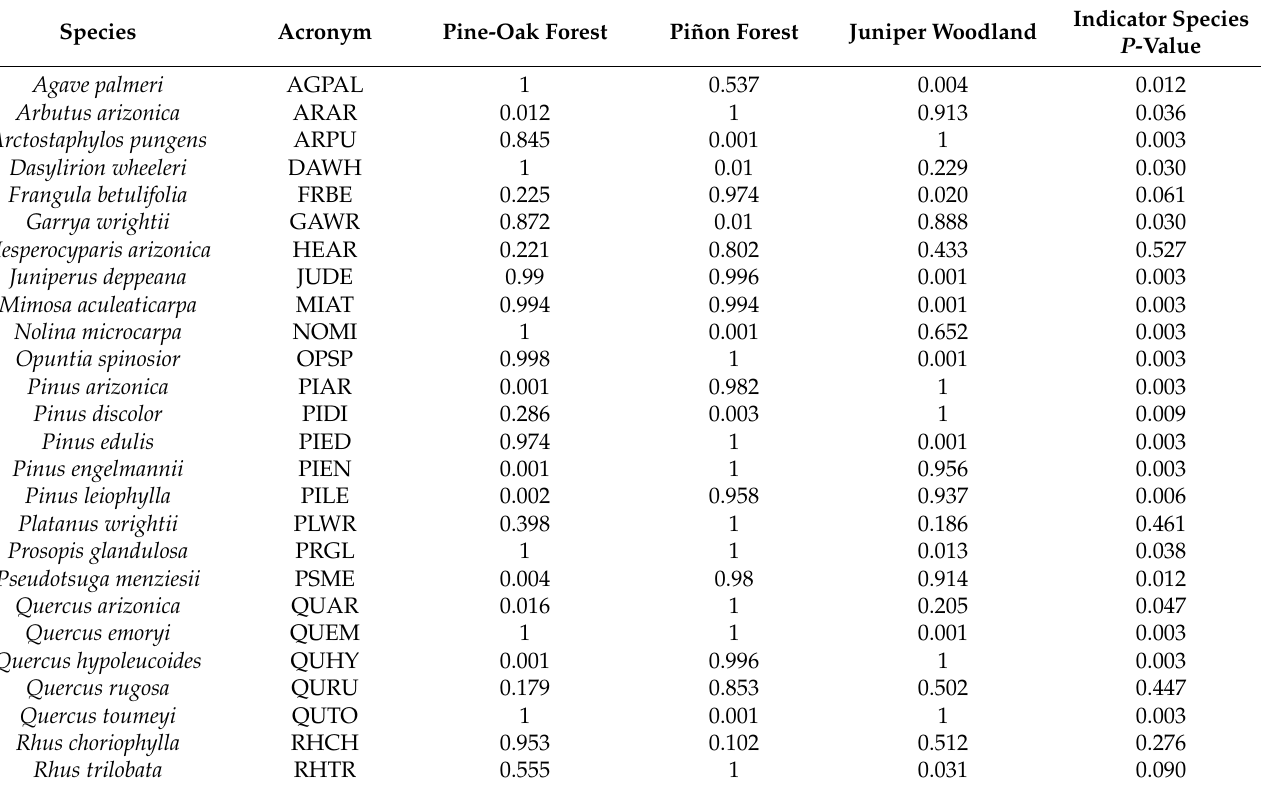
Table 3. Indicator species analysis results indicating the fidelity of species occurrence in each of the three major vegetation types in Chiricahua National Monument, Arizona. Indicator values are shown for each species within each vegetation type, which was calculated as the probability of finding the species in samples belonging to that vegetation